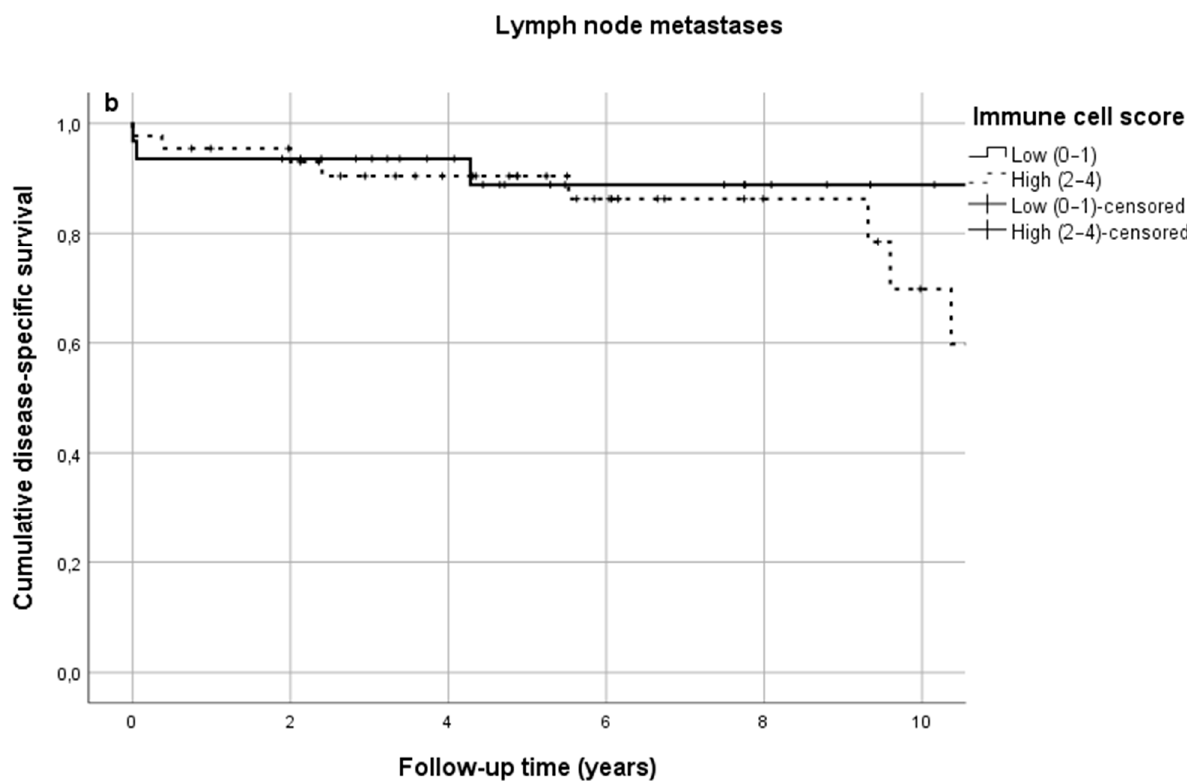
Figure 3. ( a ) Cumulative disease-specific survival in primary small bowel neuroendocrine tumors stratified by immune cell score; ( b ) cumulative disease-specific survival in small bowel neuroendocrine tumor lymph node metastases stratified by immune cell score. Table 3. Hazard ratios (HRs) for disease-specific mortality with 95% confidence intervals (CIs) in primary small bowel neuroendocrine tumors and lymph node metastases in low and high immune cell score